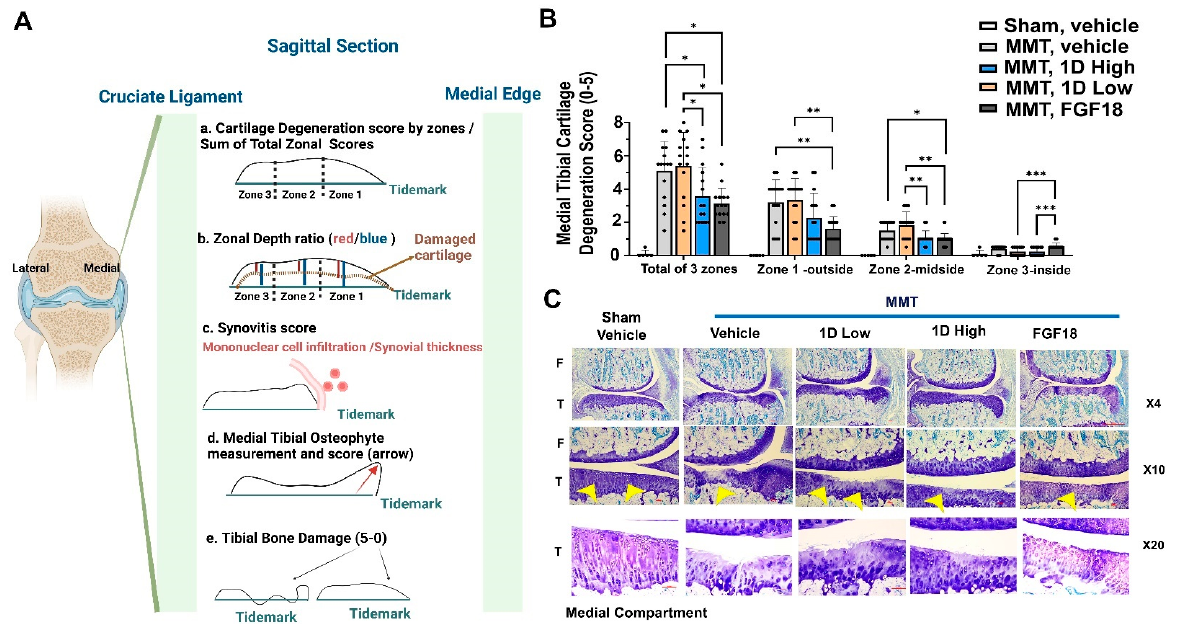
Figure 4. MMT Histopathological Profiling and Cartilage Degenerative scores: ( A ) Exhibits the post-sacrifice histopathological scores employed for the sagittal section of the medial tibial plateau, including (a) cartilage zonal and total degenerative scores; (b) zonal and average depth ratios; (c) synovitis scores; (d) osteophyte measurements and scores; and (e) calcified cartilage (i.e. tibial bone) damage scores. ( B ) Represents cartilage zonal and total degenerative scores for all five experimental groups. These scores exhibit zone-related and cumulative zone-related damage as per the scoring table in SD3 criteria, and are based on toluidine blue-stained sections ( C ). Representative sections exhibiting dark blue–purple stains depict medial articular cartilage, while light green-blue staining is of connective tissue, bone, and marrow. Medial compartment are shown in magnifications of × 4, × 10, and × 20 for the tibial articular defect site. The left side of the depiction denotes “F” for femur and “T” for tibia. Yellow arrows point towards the cartilage surface, which is intact in Shams, yet damaged in MMT administered with the vehicle. Statistical significance between treatments and control was examined via the Kruskal–Wallis test with a Dunn’s post hoc analysis for scored (non-parametric) parameters, considering p < 0.05 (*) to be statistically significant. ** p < 0.01; *** p < 0.001. Sham, n = 5; MMT-Vehicle n = 15; MMT-1D, low dose 8 µ g n = 15; MMT-1D, high dose 24 µ g n = 15; and MMT-FGF18 3 µ g n =